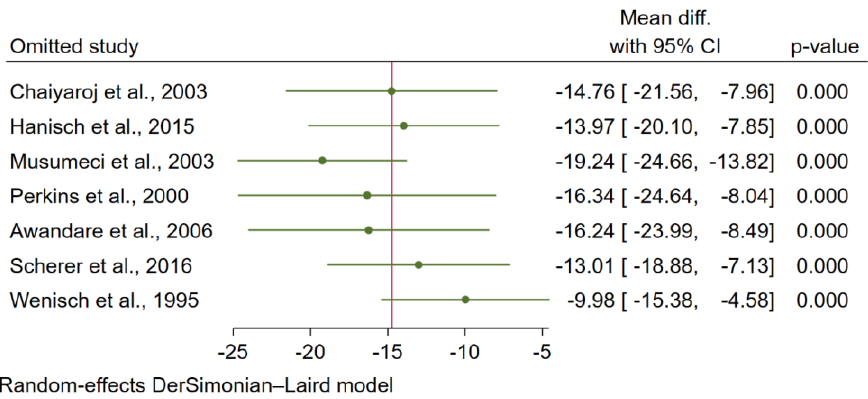
Figure 6. Sensitivity analysis determining the robustness of the meta-analysis results of the differ- ence in TGF-β levels (pg/mL) between uncomplicated malaria and healthy controls